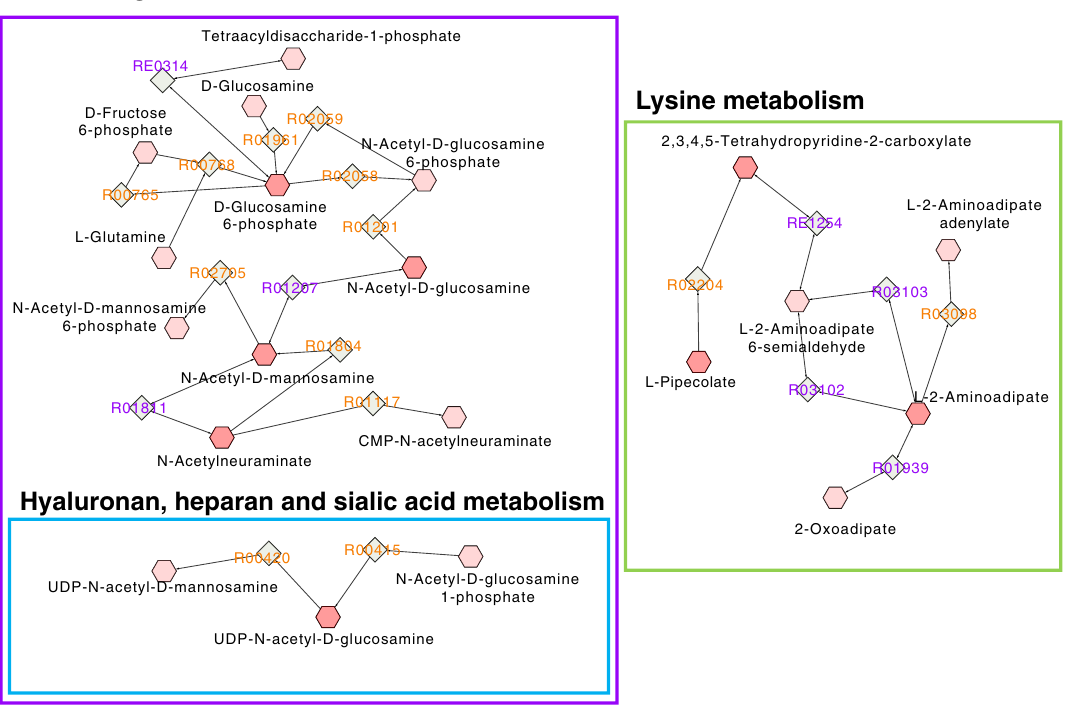
Figure 3. Overview of metabolic pathways underlying the differentiation of the fecal metabolome of HD patients (n = 34) and their healthy siblings (n = 21). The network demonstrates connected metabolic features (hexagons) with corresponding enzyme reaction (diamonds) within statistically significant (p < 0.05)